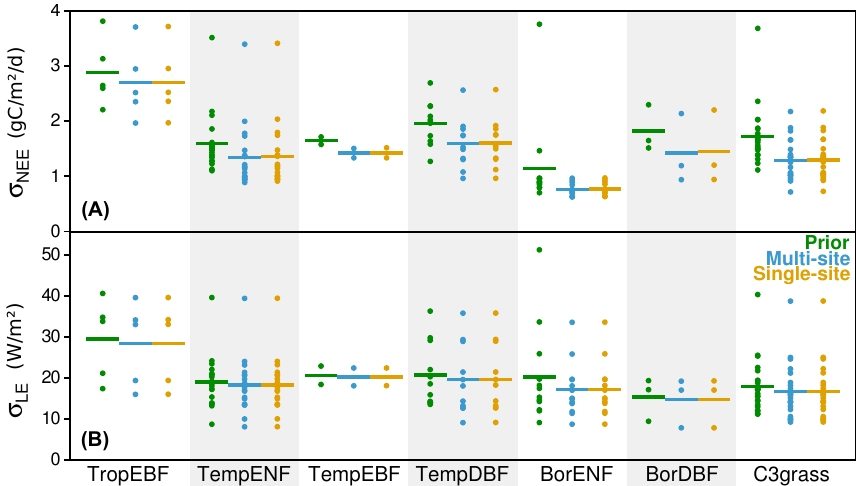
Figure 4. Uncertainty of simulated daily (a) NEE and (b) LE fluxes. For each PFT, the horizontal lines give the average of the individual site values (filled circles) in three cases: prior model (green), multisite optimization (blue) and single-site optimization